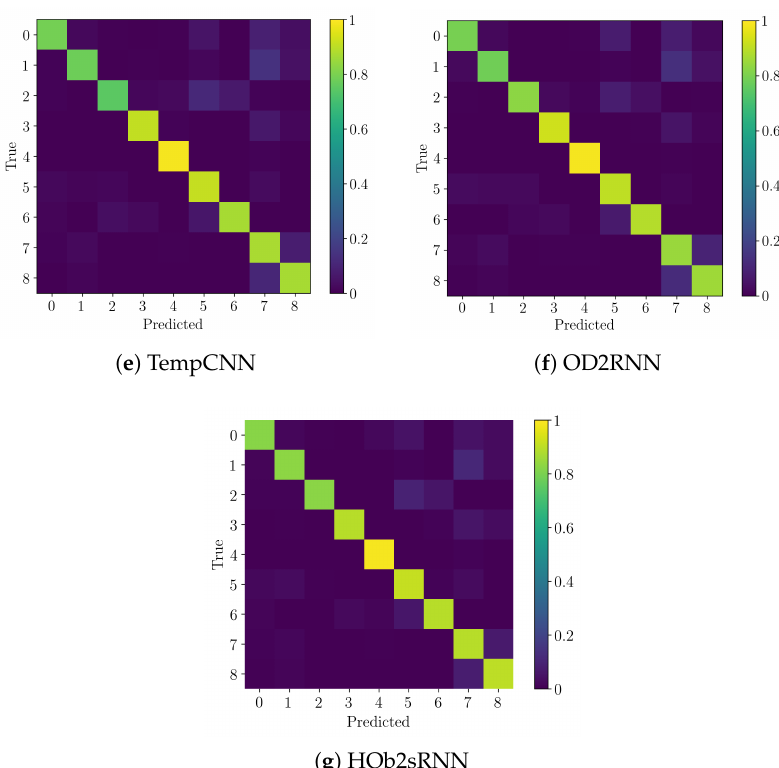
Figure 12. Confusion matrices of the land cover classification produced by ( a ) RF POE , ( b ) RF, ( c ) SVM, ( d ) MLP, ( e ) TempCNN, ( f ) OD2RNN and ( g ) HOb2sRNN on the Senegalese site. See Table 2 for corresponding